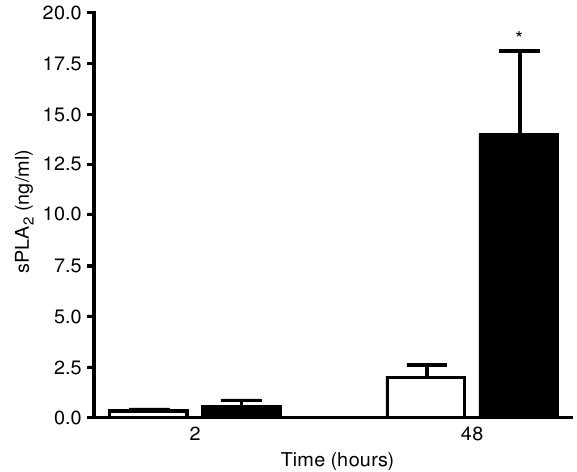
FIG. 3. Effect of anti-TNF a antibody (3 mg / kg i.v.) on sPLA 2 levels at 2 and 48 hours following LPS (100 m g / cavity) administration (n = 4). Control, open bars; treated, ® lled bars. P , 0.05. Student’s